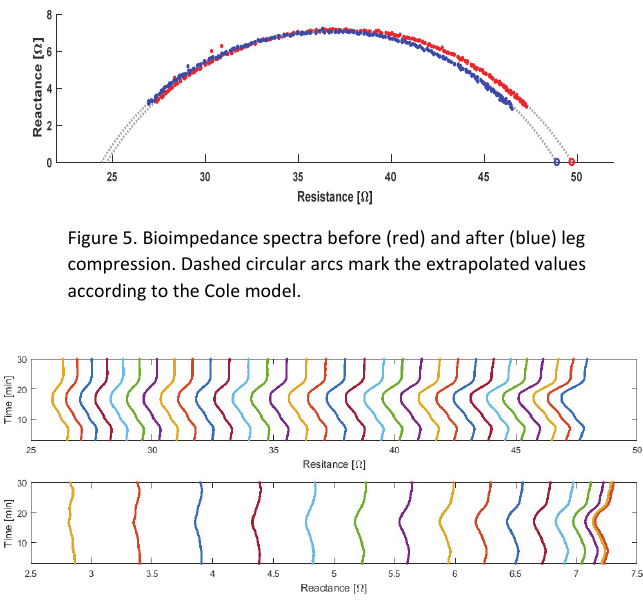
Figure 6. Bioimpedance trends at multiple frequencies in one study subject. Each line is a local regression curve indicating the temporal evolution of resistance (top) and reactance (bottom) for a single frequency on the Cole arc. Local regression is used to suppress cardio-respiratory artifacts. The trends show a linear decrease in bioimpedance (resistance and reactance) during the inflation of the leg sleeves, a plateau during the maintenance of the target pressure, and a return to baseline after the release of pressure from the leg sleeves. The decrease in resistance and reactance reflects the translation and the contraction of the Cole arc,